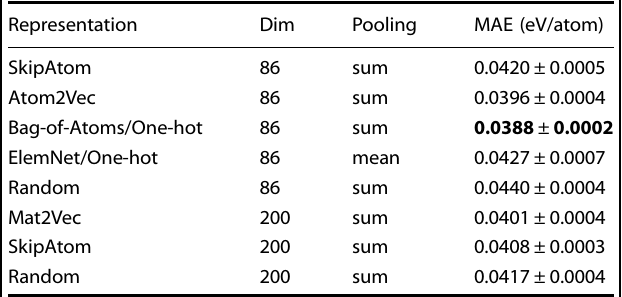
Table 5. OQMD dataset formation energy prediction results after ten- fold cross-validation; mean best formation energy MAE on the test set after 100 epochs of training in each fold. Representation